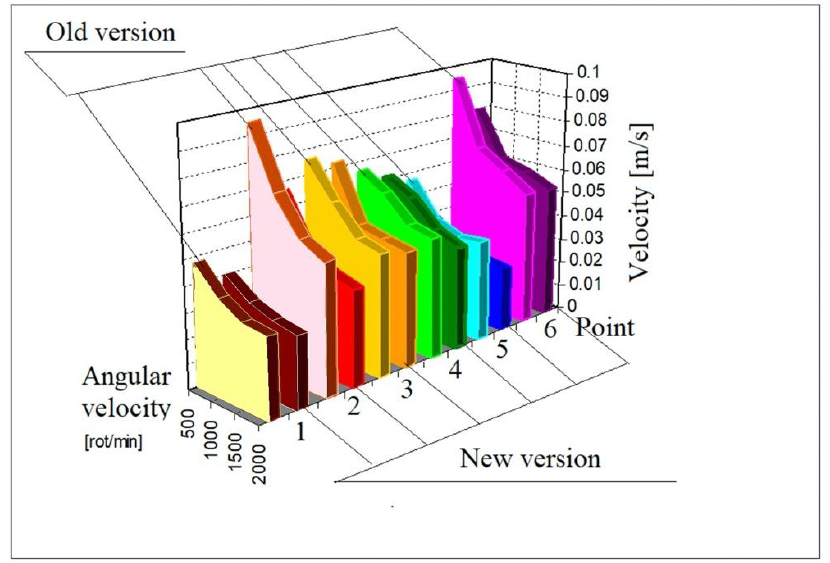
Figure 39. Synthesis of velocities measured on the housings of the two adder